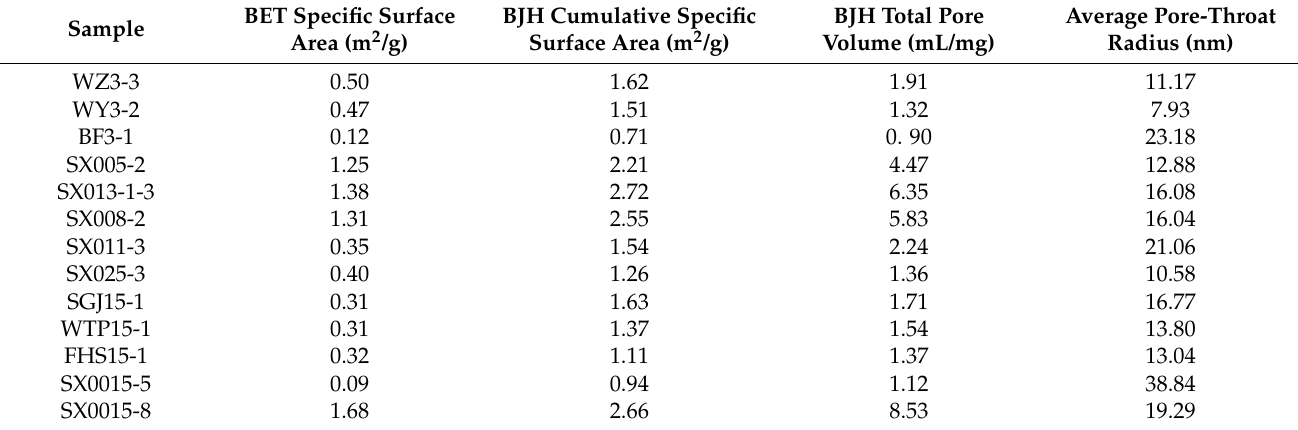
Table 4. Nitrogen adsorption data of coal reservoir samples in the south of Qinshui